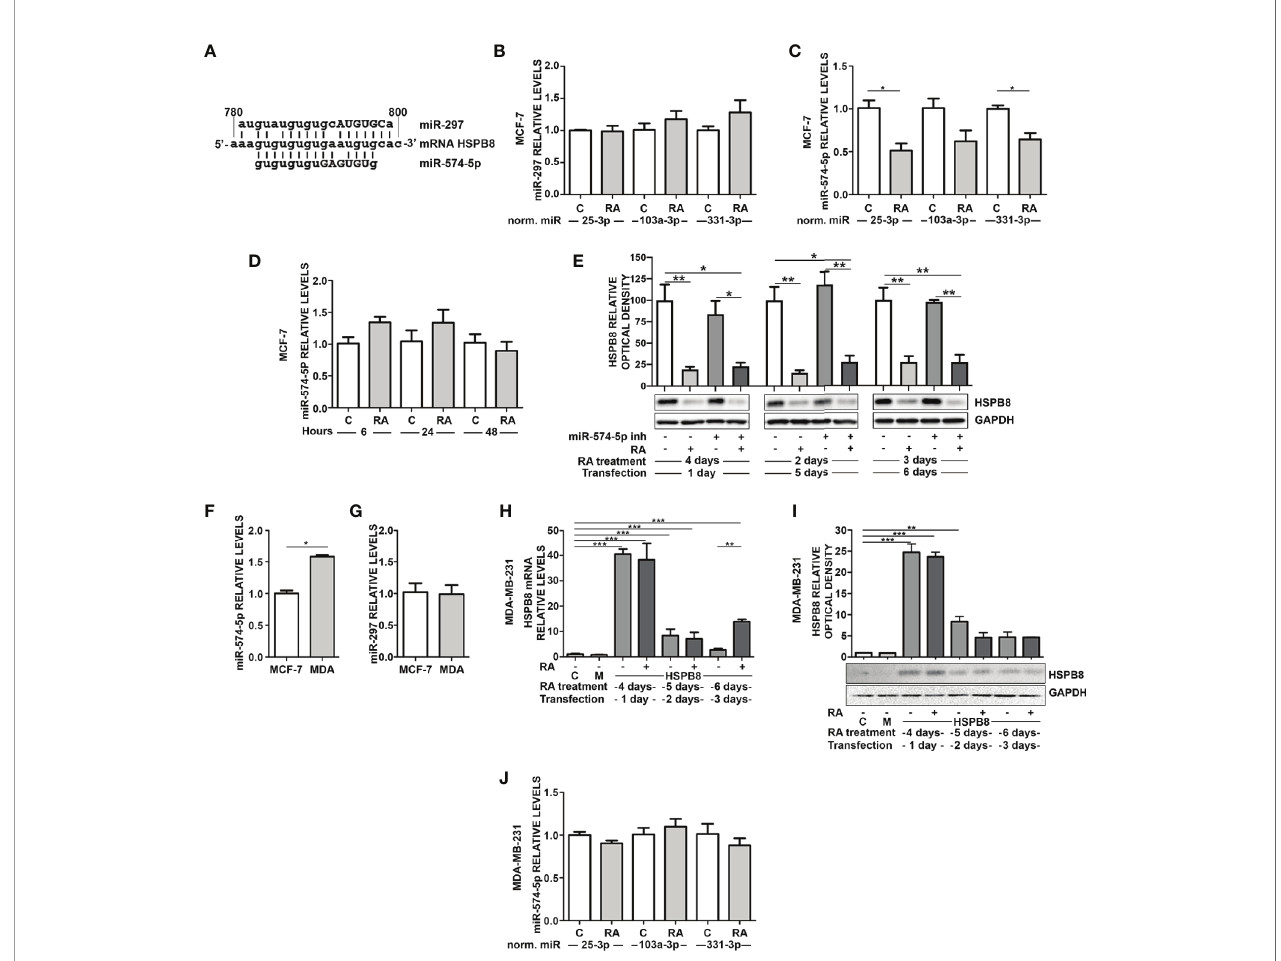
FIGURE 3 | RA modulates miRNAs in MCF-7 and MDA-MB-231 cells. (A) Alignment of miR297 and miR-574-5p RNAs with wild-type HSPB8 mRNA ORF region (between 780 and 800 bp), capital letters indicate the seed sequence of the two miRNAs. (B) RT-qPCR analysis of miR-297 in MCF-7 cells. (C) RT-qPCR analysis of miR-574-5p in MCF-7 cells. (D) RT-qPCR analysis of miR-574-5p in MCF-7 cells treated for 6h, 24h, and 48 h with 1 m M RA, data are normalized utilizing miR-25- 3p. (E) HSPB8 protein levels measured by western blot analysis in MCF-7 cells treated up to 6 days with 1 m M RA and 1, 2 and 3 days after transfection with miR- 574-5p-inhibitor. (F) RT-qPCR analysis of miR-574-5p in MCF-7 and MDA-MB-231 (MDA) cells, data are normalized utilizing RNA UniSp6 levels. (G) RT-qPCR analysis of miR-297 in MCF-7 and MDA-MB-231 (MDA) cells, data are normalized utilizing RNA UniSp6 levels. (H) HSPB8 mRNA levels measured by RT-qPCR analysis in MDA-MB-231 cells. (I) HSPB8 protein levels measured by western blot analysis in MDA-MB-231 cells. For (H, I) untreated cells (C), mock-transfected cells (M) or cells treated up to 6 days with 1 m M RA and transfected at day 3 with the plasmid overexpressing wild-type HSPB8. Analyses were performed at 1, 2 and 3 days after transfection. (J) MDA-MB-231 cells treated for 4 days with 1 m M RA. All miRNAs RT-qPCR analysis are normalized utilizing miR-25-3p, miR-103a-3p or miR-331-3p as housekeeping microRNA. *p < 0.05; **p < 0.01; ***p < 0.005 in all charts. Graph bars represent the mean of three independent